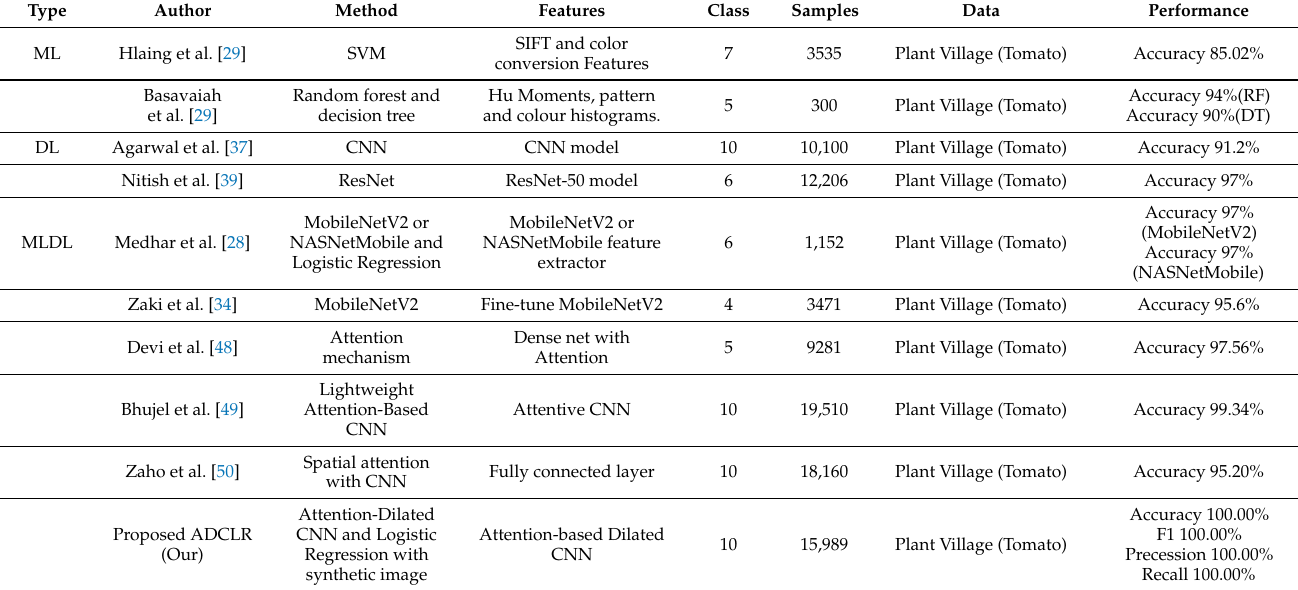
Table 7. The performance comparison of the related studies with the proposed approach. DL: Deep Learning, ML = Machine Learning, DLML = Deep learning with Machine